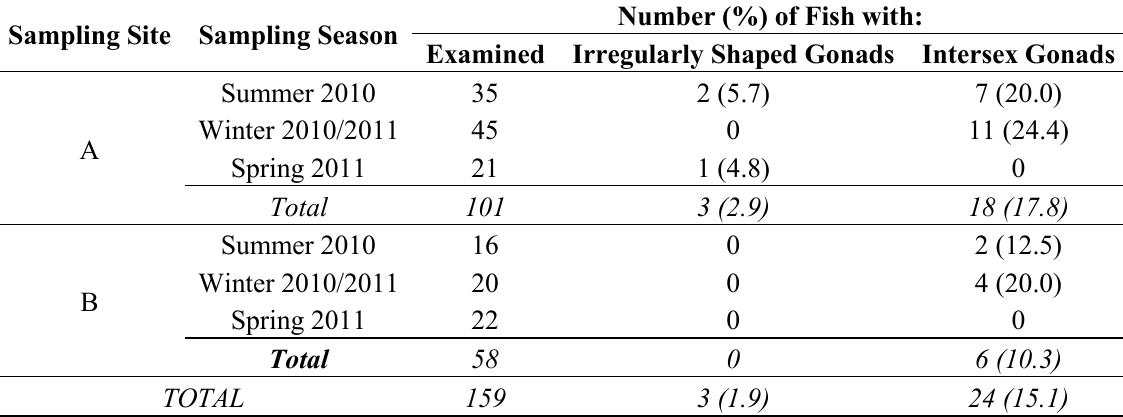
Table 4. Prevalence of gonadal anomalies in thinlip grey mullets collected from the Tiber river sites A and